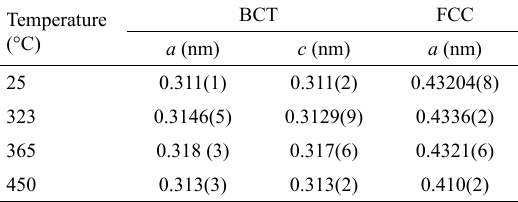
Table 1: Lattice parameters of the BCT and FCC phases in 52Ti- 12V-36Cr+4%wt. Zr Ni alloy in function of temperature as 7 10 deduced from Rietveld refinement of the synchrotron radiation patterns. Numbers in parenthesis are one standard deviation of the last significant digit.